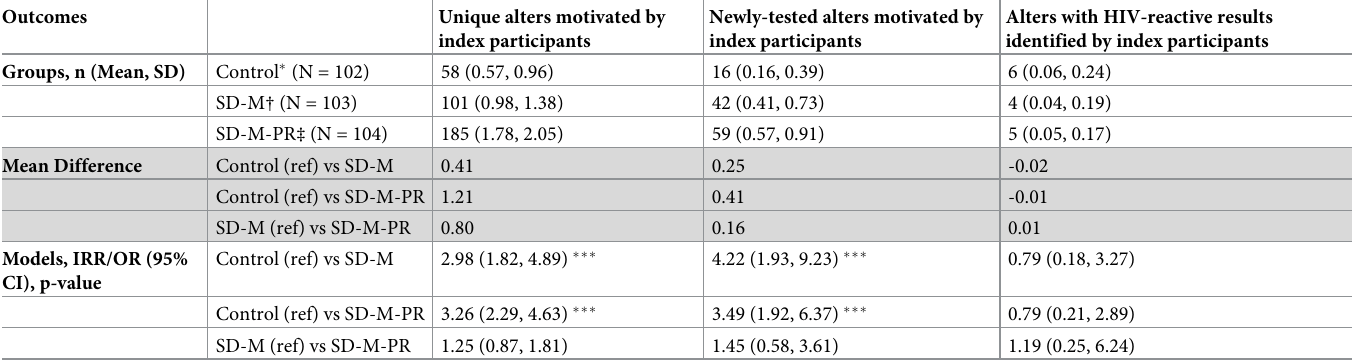
Newly-tested alters motivated by Alters with HIV-reactive results index participants index participants identified by index participants